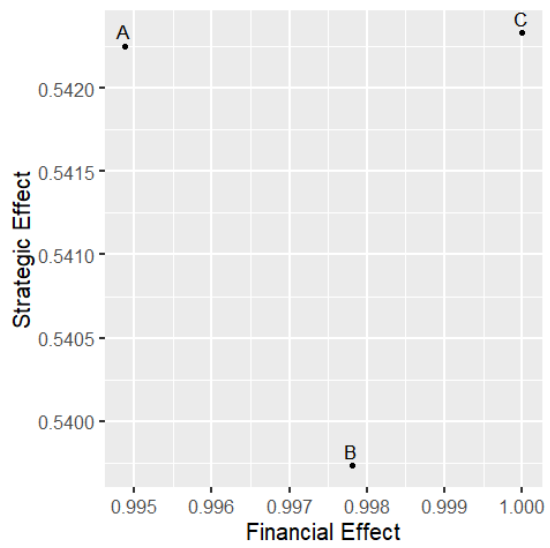
Figure 5. Weighted influence nonlinear gauge system (WINGS): total relative involvement of Financial and Strategic Effects caused by Offers A, B, and C.